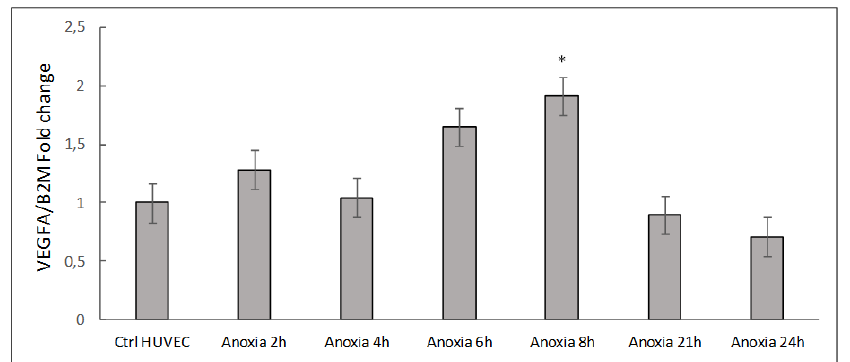
Figure 1. Analysis of mRNA levels of VEGFA in cell extracts of HUVECs exposed to anoxia stimulus from 2 to 24 h. Values are expressed as mean ± SD; n = 2, * p < 0.05 compared with normoxic cells.